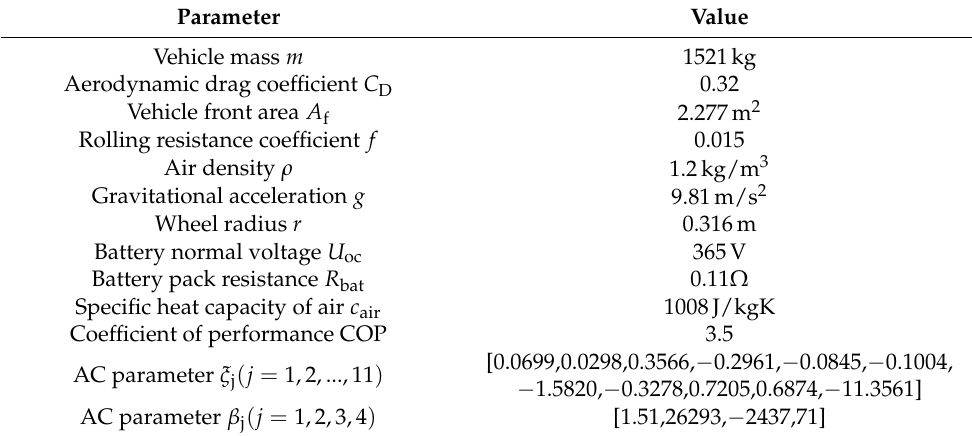
Table 1. Parameters of the EV and AC models.